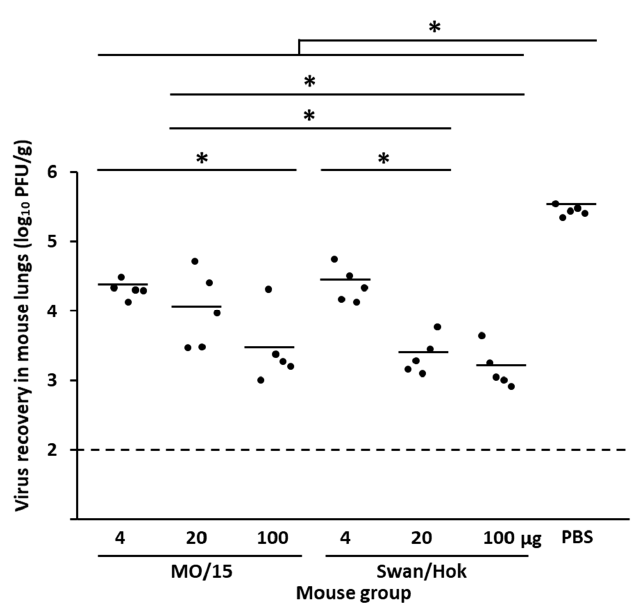
Figure 4. Virus recovery in the lungs of mice subcutaneously vaccinated twice with various amounts